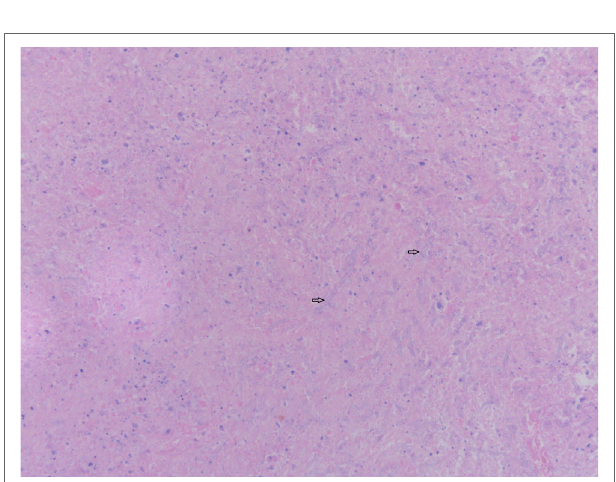
FIGURe 5 | Skin biopsy with presence of fungal hyphae. Periodic Acid Schiff stain on skin biopsy with fungal hyphae stained purple. Two fungal hyphae with dichotomous branching (diagnostic of Aspergillus ) are depicted (arrows).